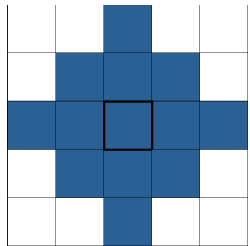
Figure 6. A 5 x 5 square neighborhood used for detecting the center of clusters of at least 13 pixel-size Part D. Zoning